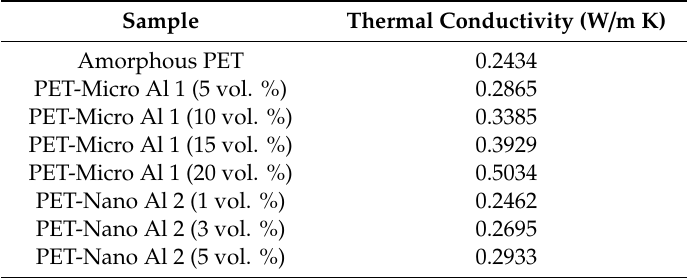
Table 12. Thermal Conductivity of amorphous PET and nano-Al / amorphous PET